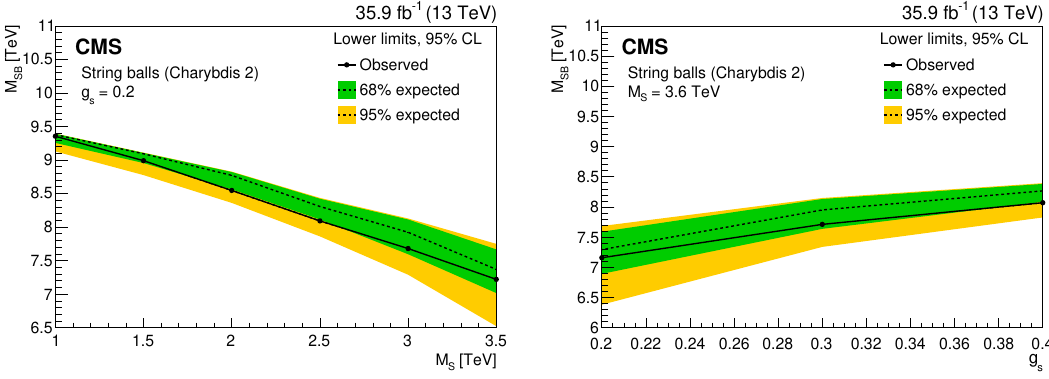
Figure 10 . The 95% observed CL lower limits on M min models C1{C6 generated with charybdis 2.